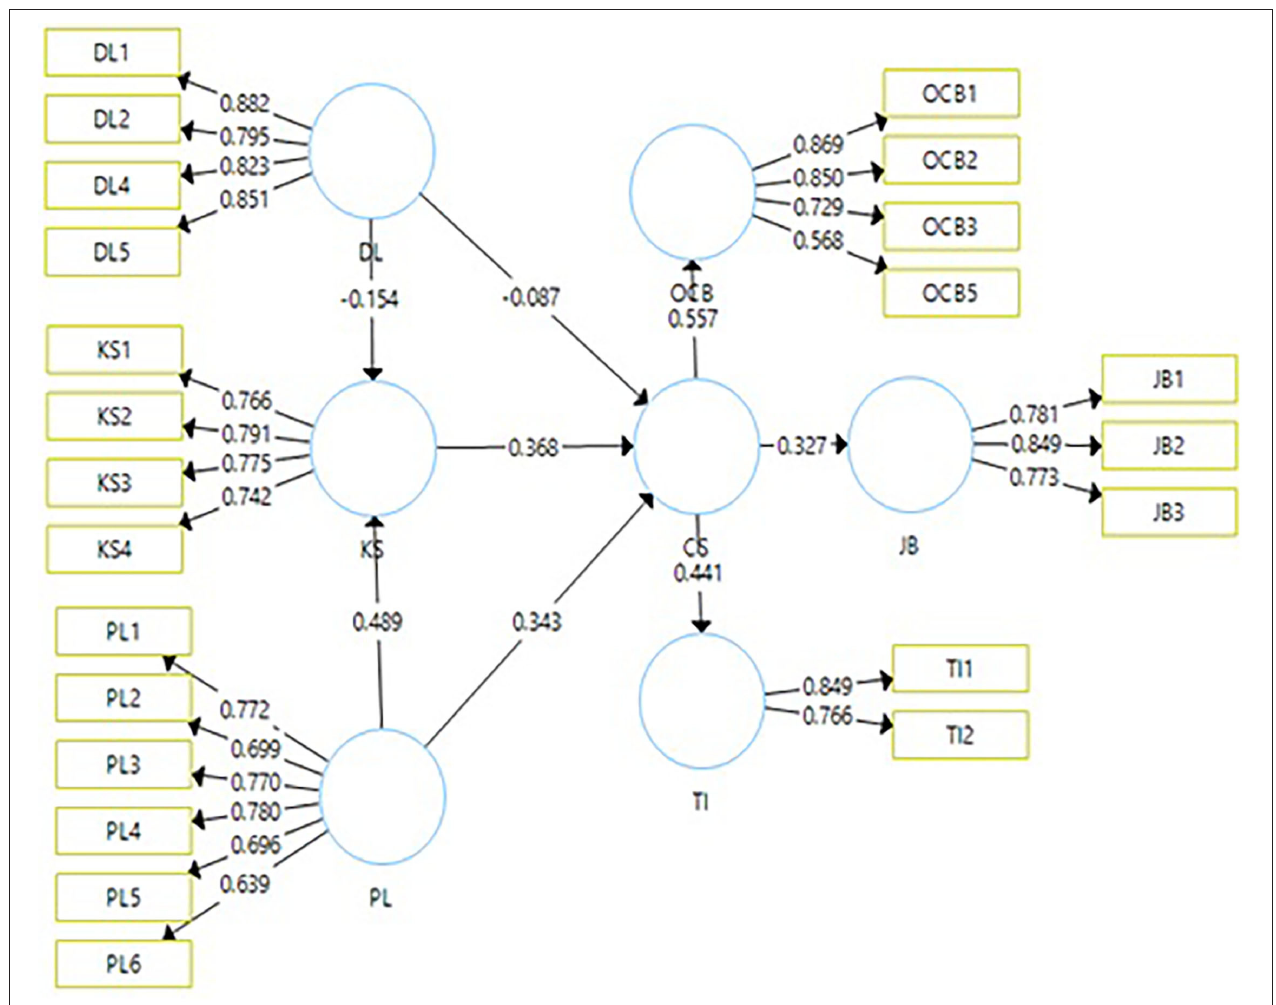
FIGURE 1 | Measurement